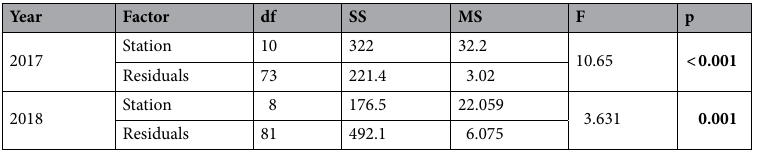
Table 2. One-way ANOVA results exploring the differences in the number of mt16S gene copies [g stomach content] −1 between different sampling stations over two separate sampling periods (years: 2017 and 2018). Significance accepted at p < 0.05 and is highlighted in bold.